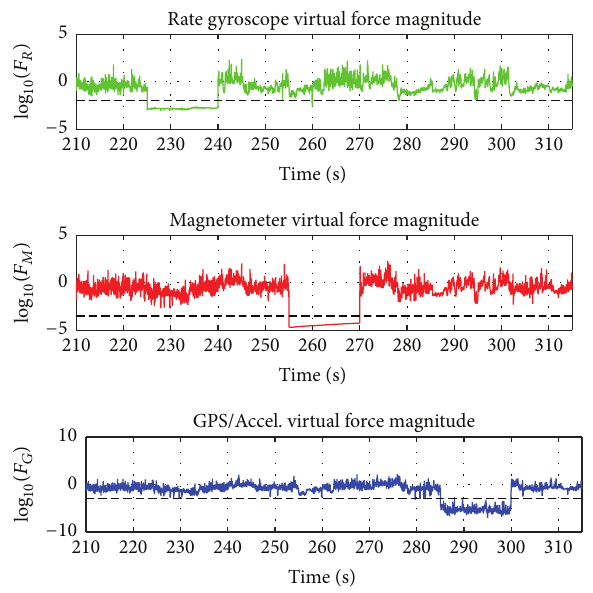
Figure 7: “Virtual Force Field” based failure detection